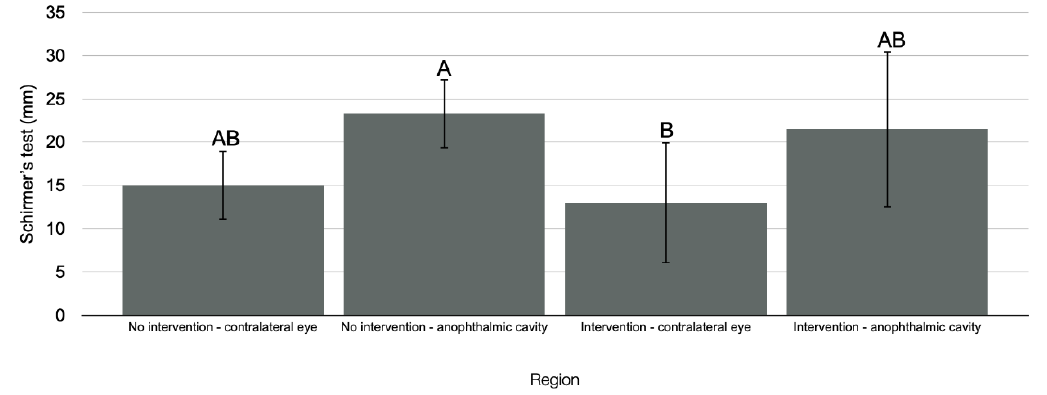
Figure 8. Tear production level in the initial period in the different regions analyzed in the IG com- pared with the NIG. Capital letters indicate a statistically significant difference (Kruskal – Wallis, p <